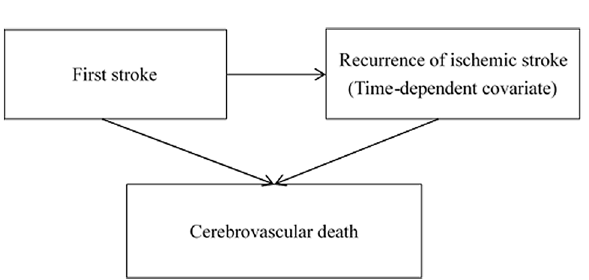
Figure 2. The disease progress process of stroke recurrence and cerebrovascular death during